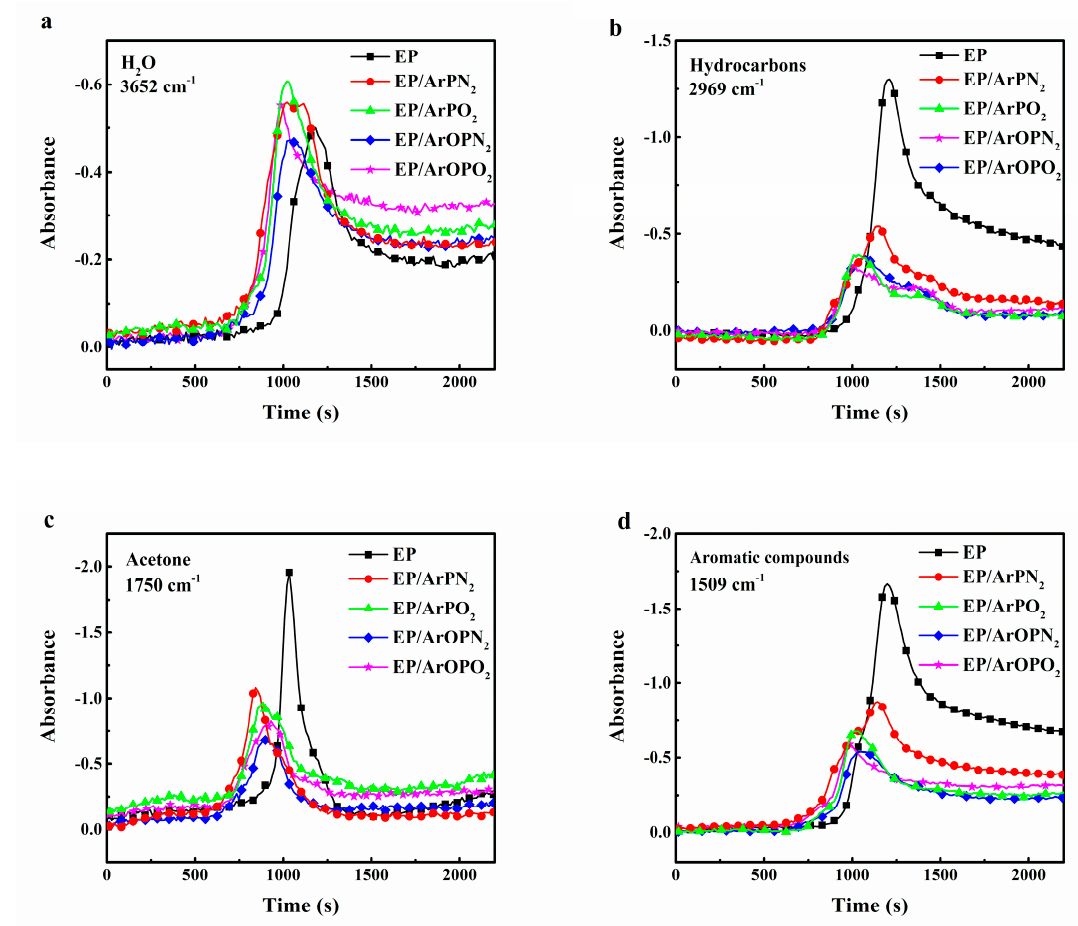
Figure 5. Absorbance of gas products for EP and EP/polysulfone composites vs. time: ( a ) H 2 O; ( b ) hydrocarbons; ( c ) acetone; ( d ) aromatic compounds.